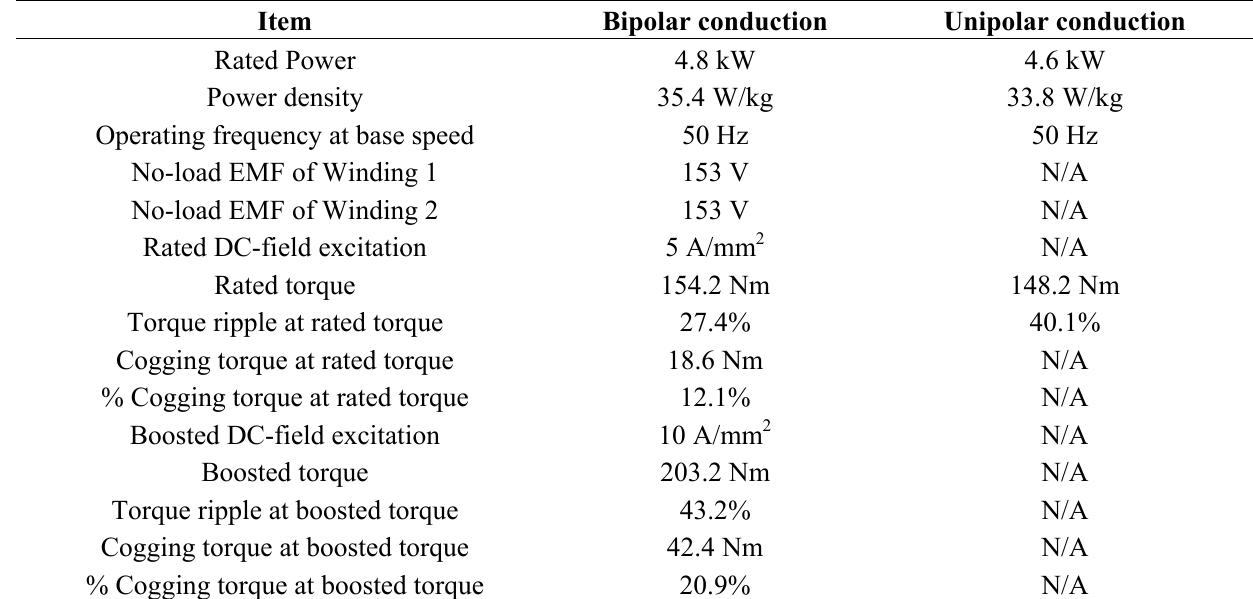
Table 4. Proposed AF-DSDC machine performances.